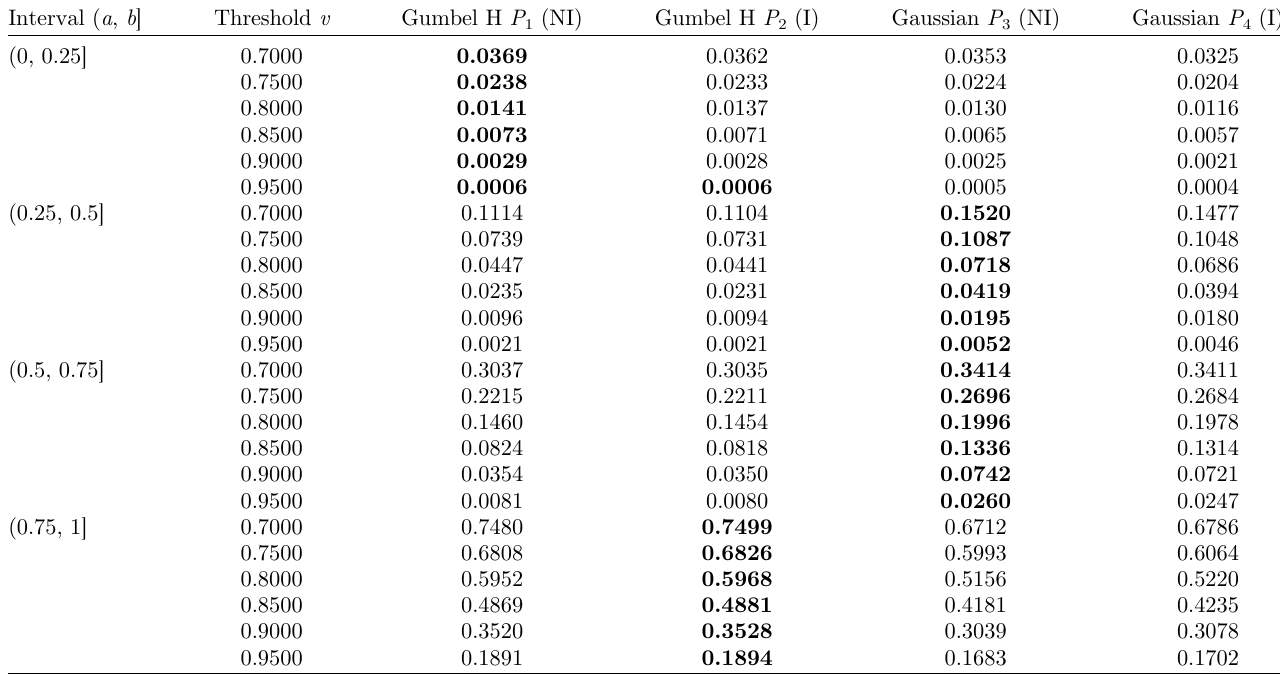
Table 4. Case H (cid:1) V F vs. D max (see Tab. 3). From left to right: interval ( a , b ], v lower threshold of V , P i = Prob i ( V > v | U 2 ( a , b